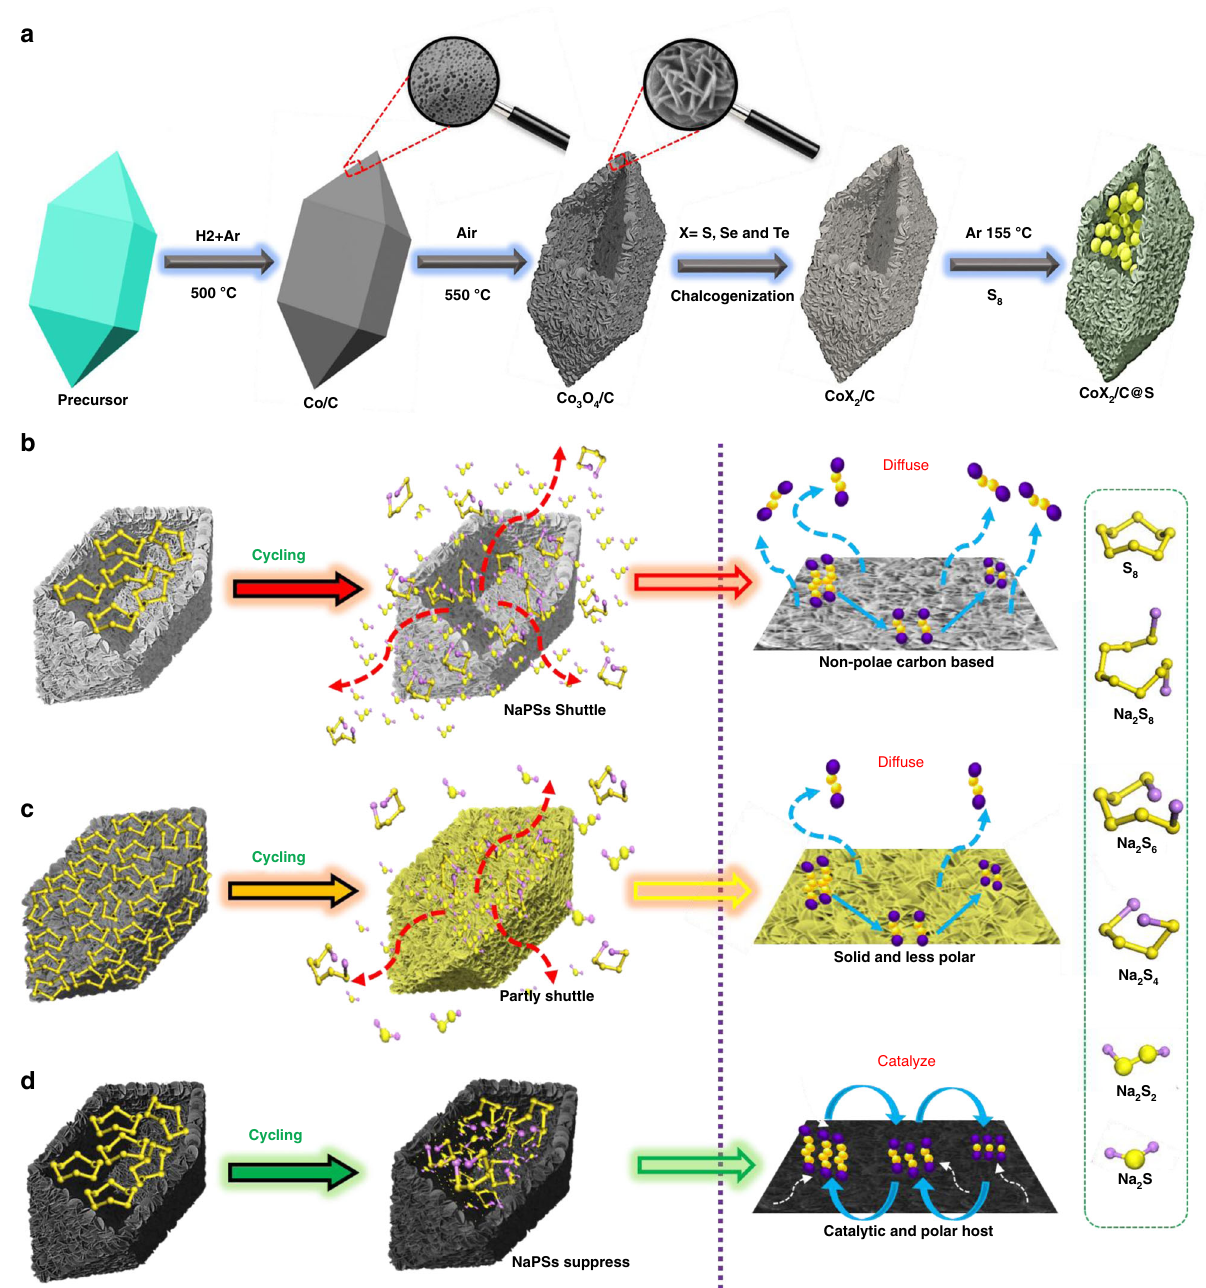
Fig. 1 Synthesis of chalcogenides and illustration of polysul fi de diffusion effect. a Synthesis of metal chalcogenide S@BPCX composites. b Nonpolar hollow carbon host. c Diffusion of NaPSs in solid nonpolar host and d suppression of NaPSs in hollow polar/catalytic